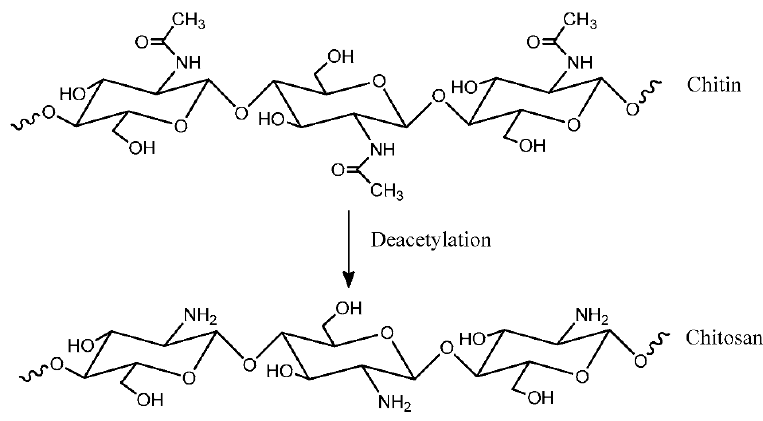
Figure 6. Molecular structure segment of chitin and chitosan.